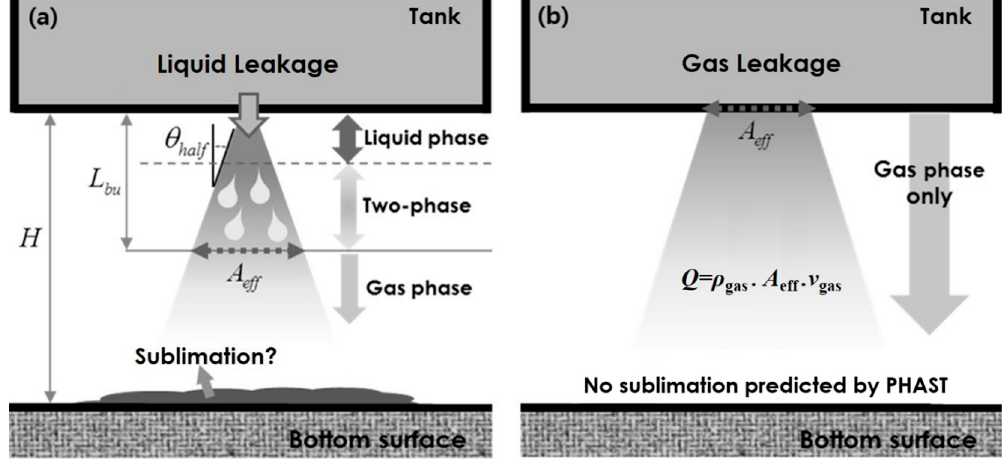
Figure 1. ( a ) Physics of phase change during leakage, and ( b ) gas leakage modeling.